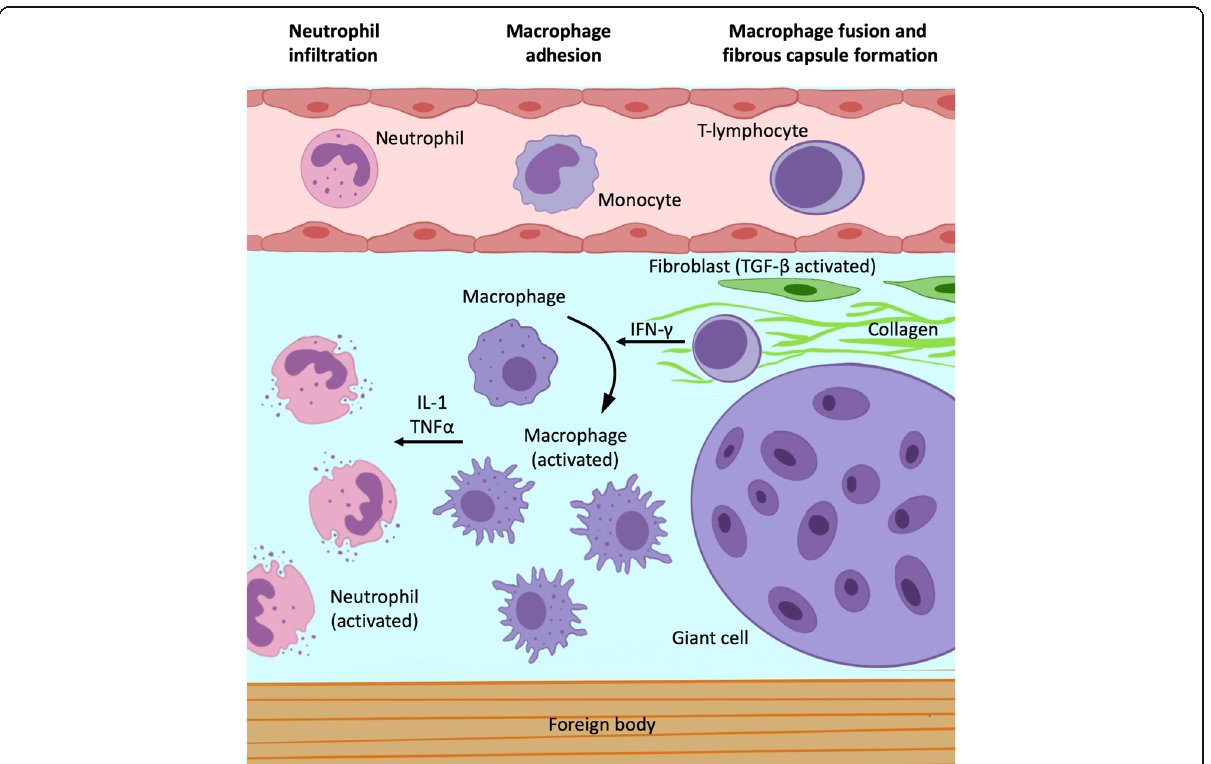
Fig. 1. Foreign body granuloma pathophysiology. The foreign body response begins with rapid neutrophil infiltration and subsequent release of soluble factors involved in monocyte circulating monocyte recruitment. These last differentiate into macrophages, which are activated by T cell lymphocytes-produced interferon- γ . In turn, activated macrophages produce interleukin-1 family cytokines and tumor necrosis factor which determine further macrophage activation and their fusion into multinucleated giant cells. After months, transforming growth factor beta releasing recruits and activates fibroblasts with fibrous capsule